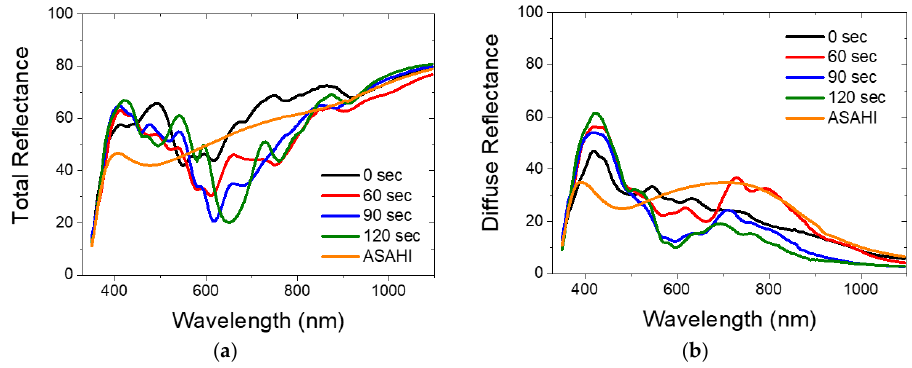
Figure 6. ( a ) Total and ( b ) diffused reflectance of hexagonal Ag/ZnO BRs and ASAHI BR with 100 nm